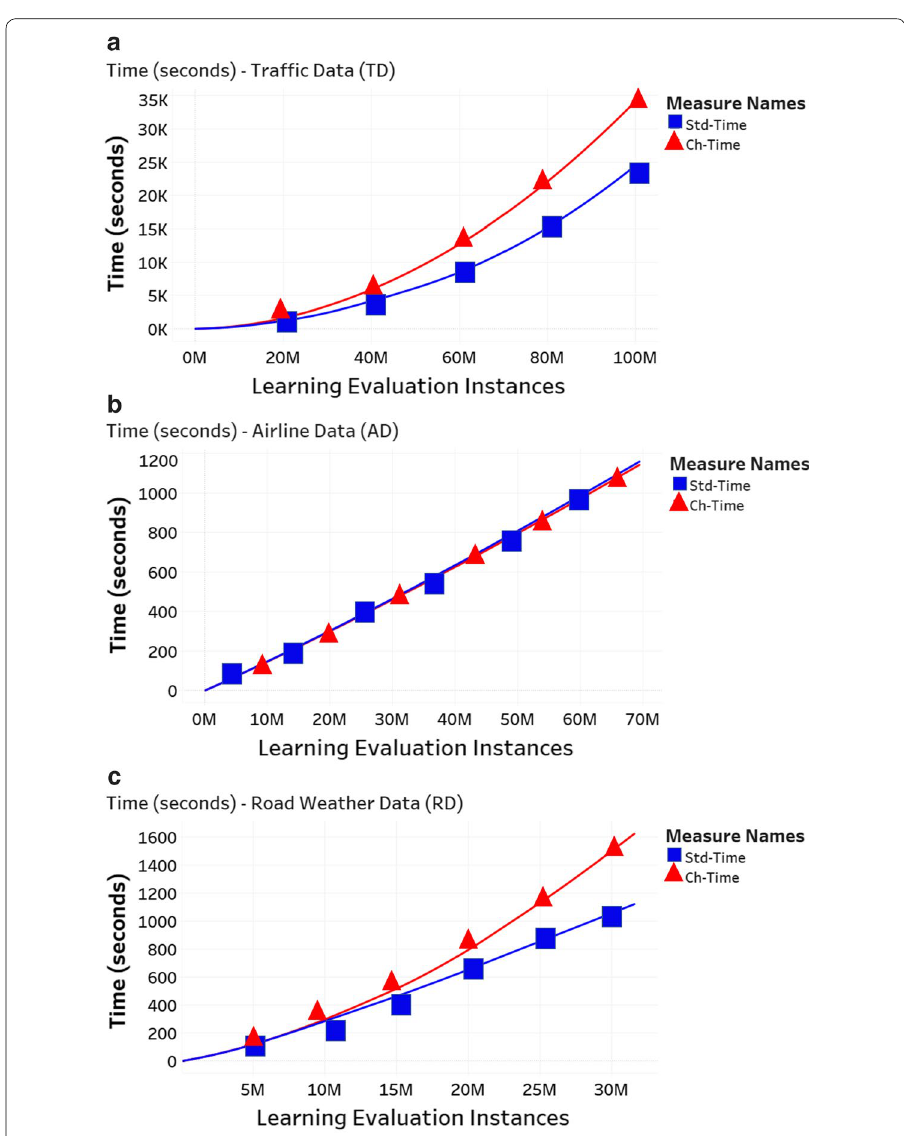
Fig. 5 Simulation time (s) of Hoeffding bound (std-time) and Chernoff bound